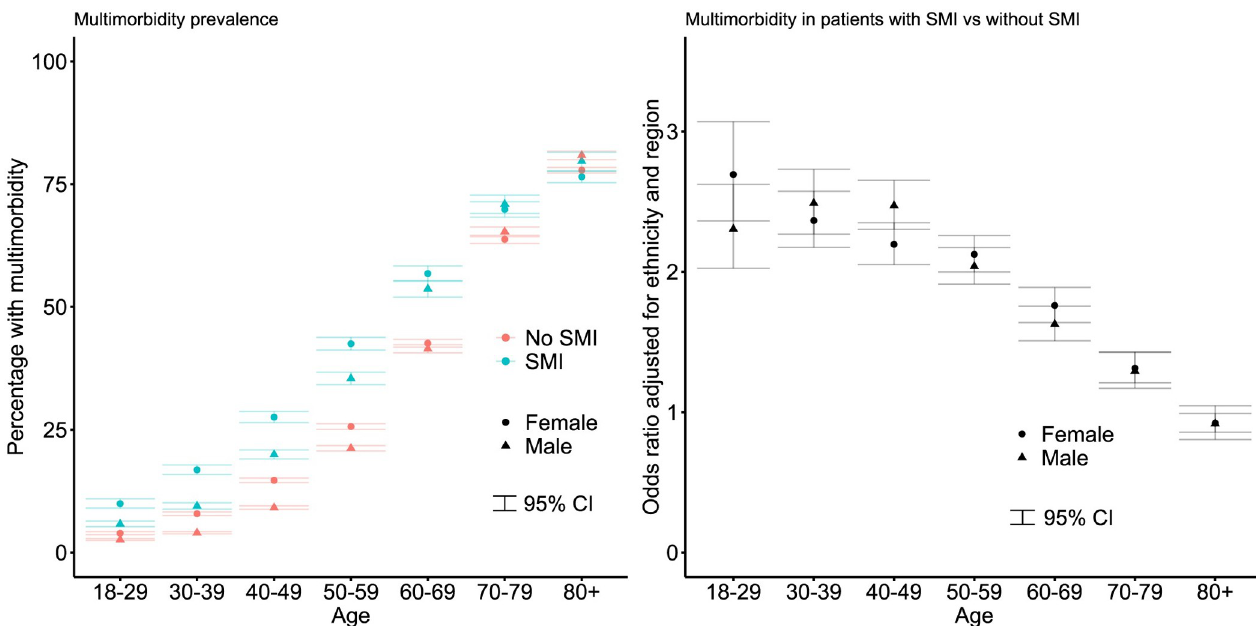
Fig 1. Prevalence of multimorbidity by SMI status, age group, and sex and OR of multimorbidity in those with SMI versus those without. CI, confidence interval; OR, odds ratio; SMI, severe mental illness.